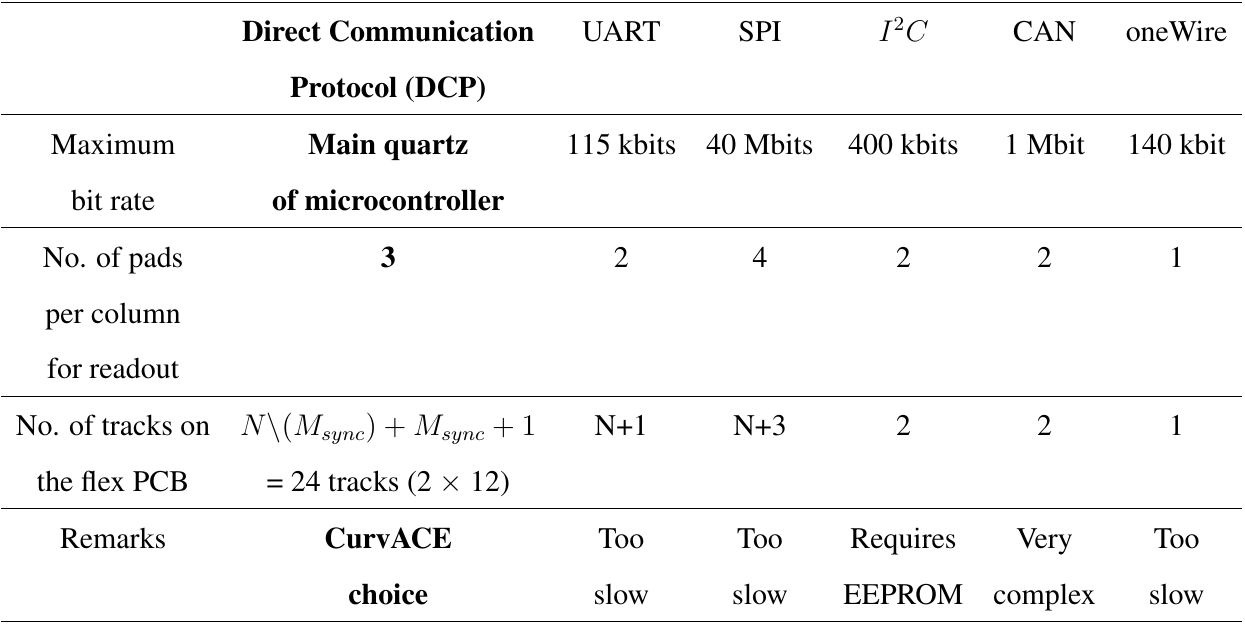
Table 1. Characteristics of various communication buses, including the one used for the CurvACE readout (in bold), with N the number of D and M the number of sync signals (equal to two for sync